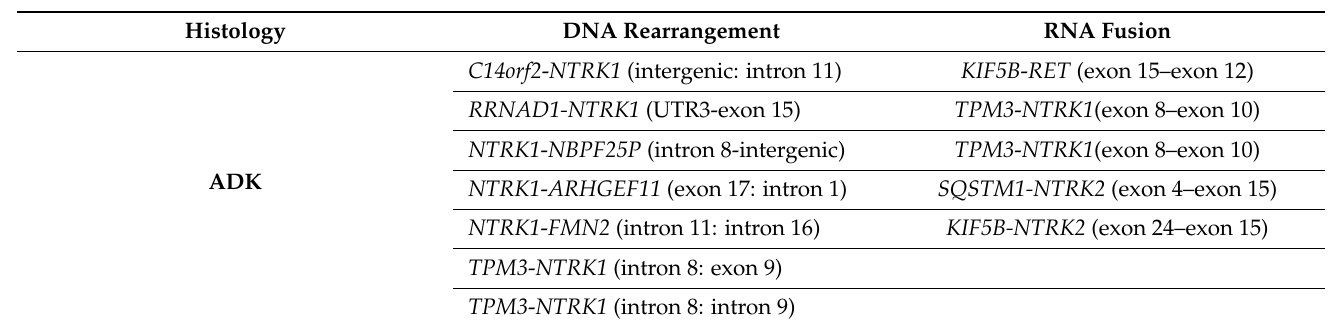
Table 6. Neurotrophic receptor tyrosine kinase (NTRK) gene fusion in lung cancer detected using NGS at DNA and RNA